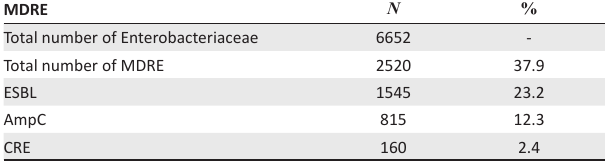
TABLE 2: Percentage of multidrug-resistant Enterobacteriaceae urinary isolates.